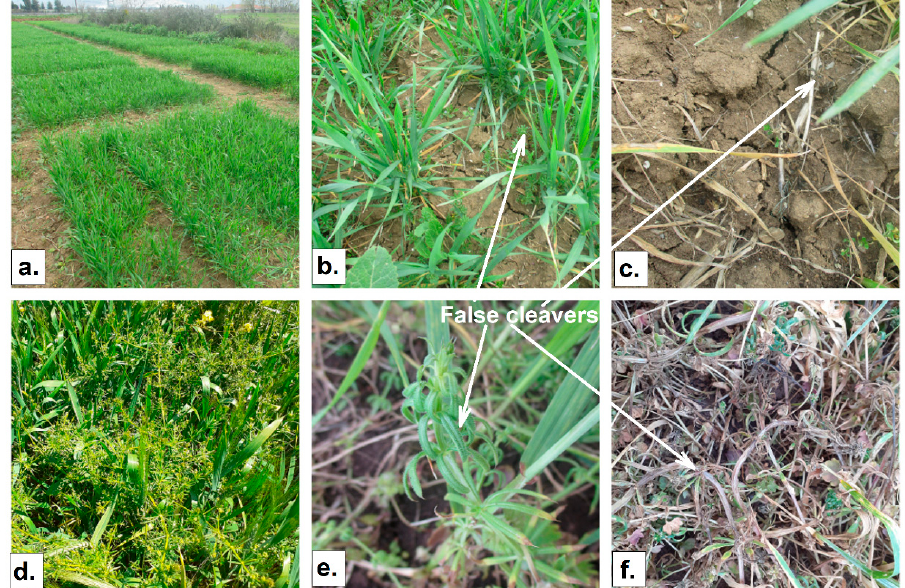
Figure 11. ( a ) The experimental field in Velestino at 14 days after herbicides application (DAA), ( b ) false cleavers growth in the metsulfuron-methyl + bensulfuron-methyl plots at 14 DAA, ( c ) necrosis of false cleavers plants in bromoxynil + 2,4-D at 14 DAA, ( d ) false cleavers growth in the control plots in Domokos, ( e ) halauxifen-methyl + florasulam symptoms on false cleavers plants at 14 DAA, and ( f ) false cleavers necrosis in the halauxifen-methyl + florasulam treatment.